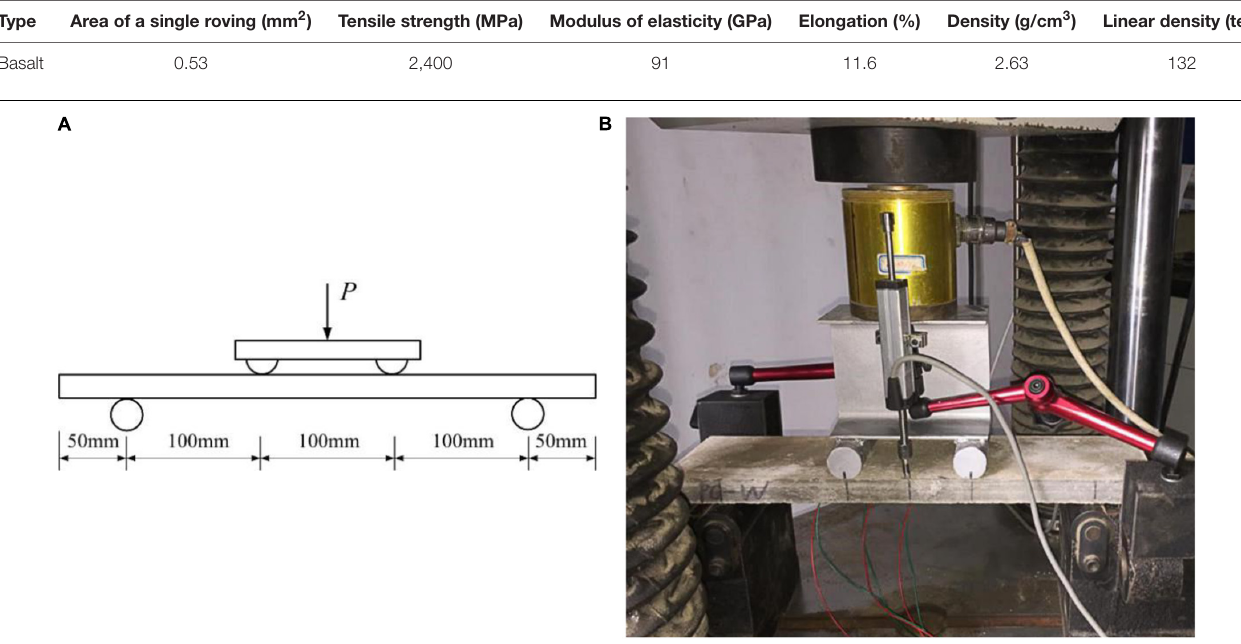
FIGURE 3 | Four-point bending test device. (A) Schematic diagram of four-point bending test. (B) Loadin device.